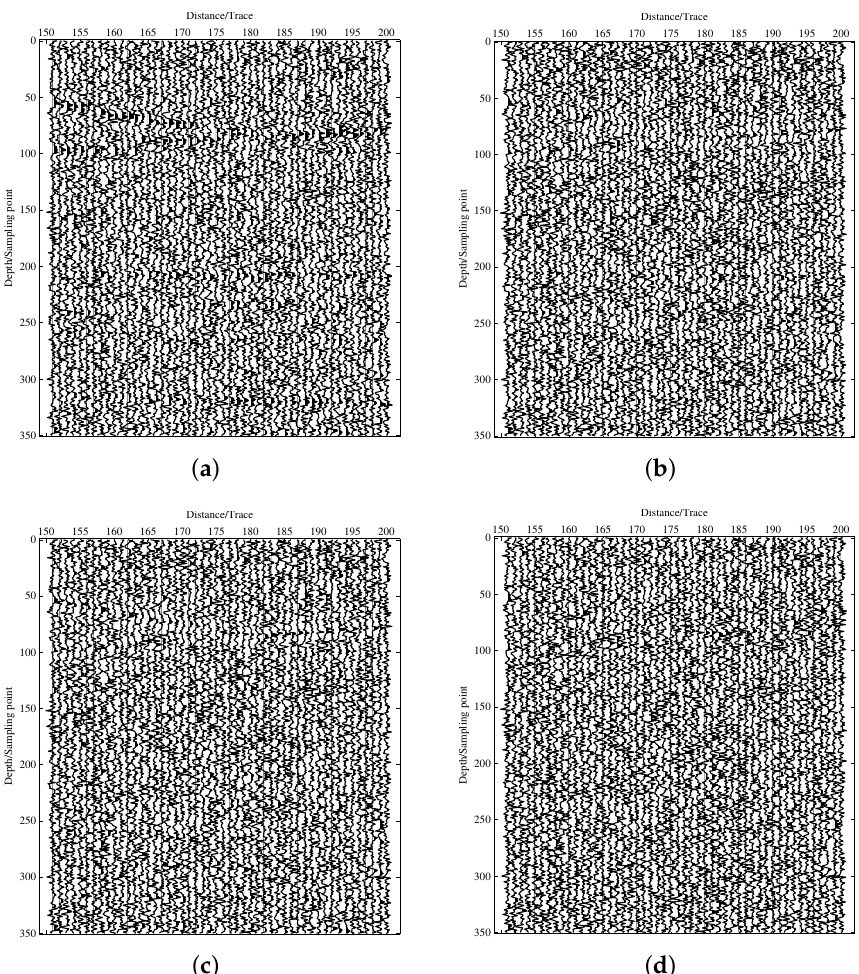
Figure 6. Waveforms of the filtered noise in traces 151–200 when the SNR of the input seismic data was 3 dB. ( a ) Filtered noise by wavelet denoising, ( b ) filtered noise by ITVD, ( c ) filtered noise by ATVD and ( d ) filtered noise by the SD-SpaLR